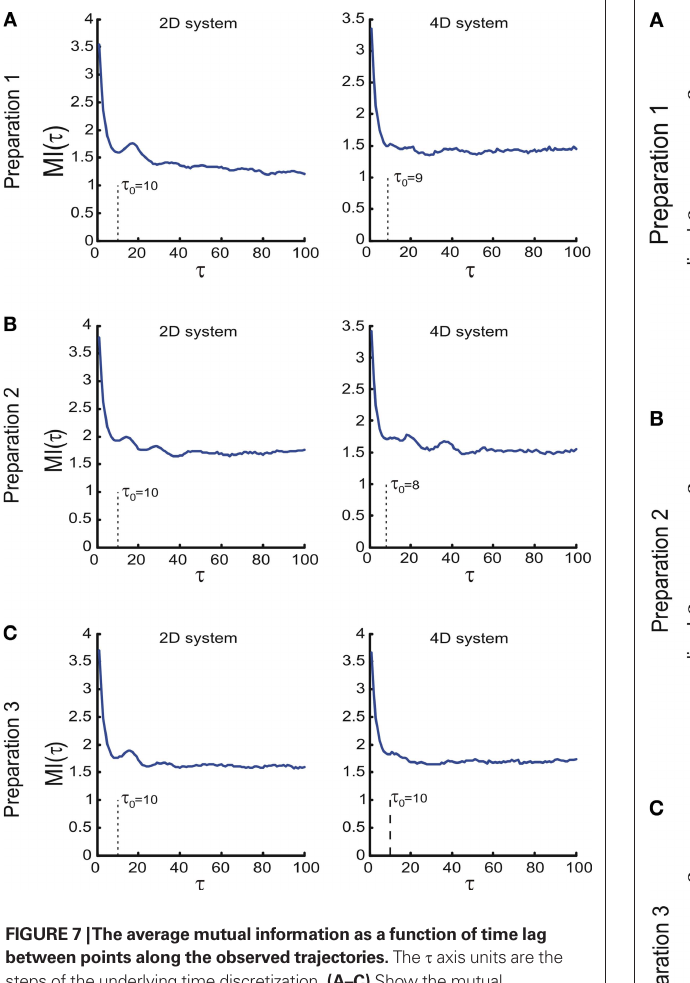
FIGURE 7 | The average mutual information as a function of time lag between points along the observed trajectories. The τ axis units are the steps of the underlying time discretization. (A–C) Show the mutual information for the three preparations respectively. Left panels show the average mutual information computed for the trajectories obtained using the 2D system, rights panels show the data for the 4D system. The time lag, for which the fi rst local minimum of the mutual information is reached, is marked in each panel by τ 0